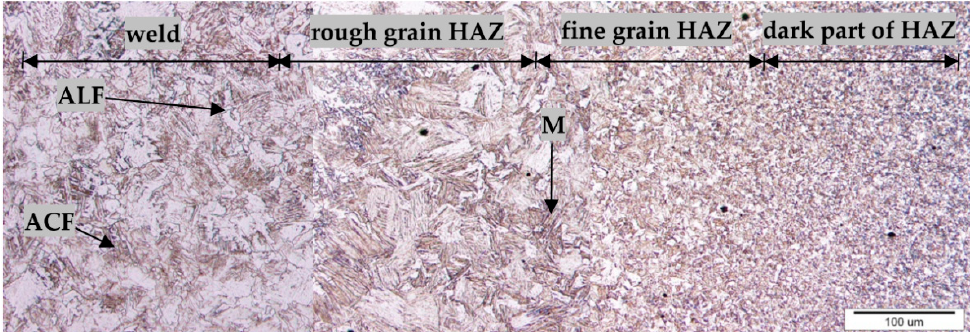
Metals 2019 , 9 , x FOR PEER REVIEW Figure 8. Microstructure of di ff erent weld region obtained at welding speed of 0.2 m / min. Figure 8. Microstructure of different weld region obtained at welding speed of 0.2 m/min .